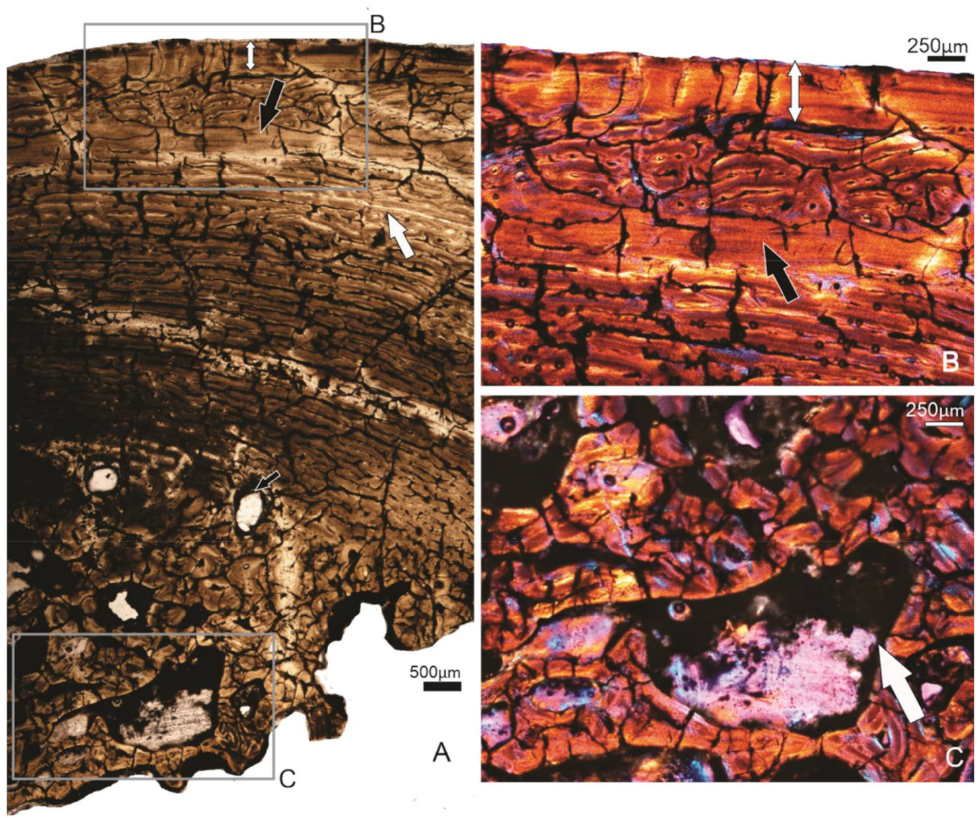
Figure 6. Specimen SAM P.53833, tibiotarsus. ( A ) Overview of the compacta. Subperiosteally, there is a wide OCL present (double-headed arrow), and further in the compacta, another wide band of lamellar tissue occurs (black arrow), below which is a narrow annulus (white arrow). Deep parts of the compacta show secondary remodelling, and several large erosion cavities are visible (small black arrow). ( B ) Higher magnification of the framed region of (A), showing the OCL and the wide inner band of lamellar tissue. ( C ) Higher magnification of the framed region in (A), showing the extensively secondary remodelled perimedullary